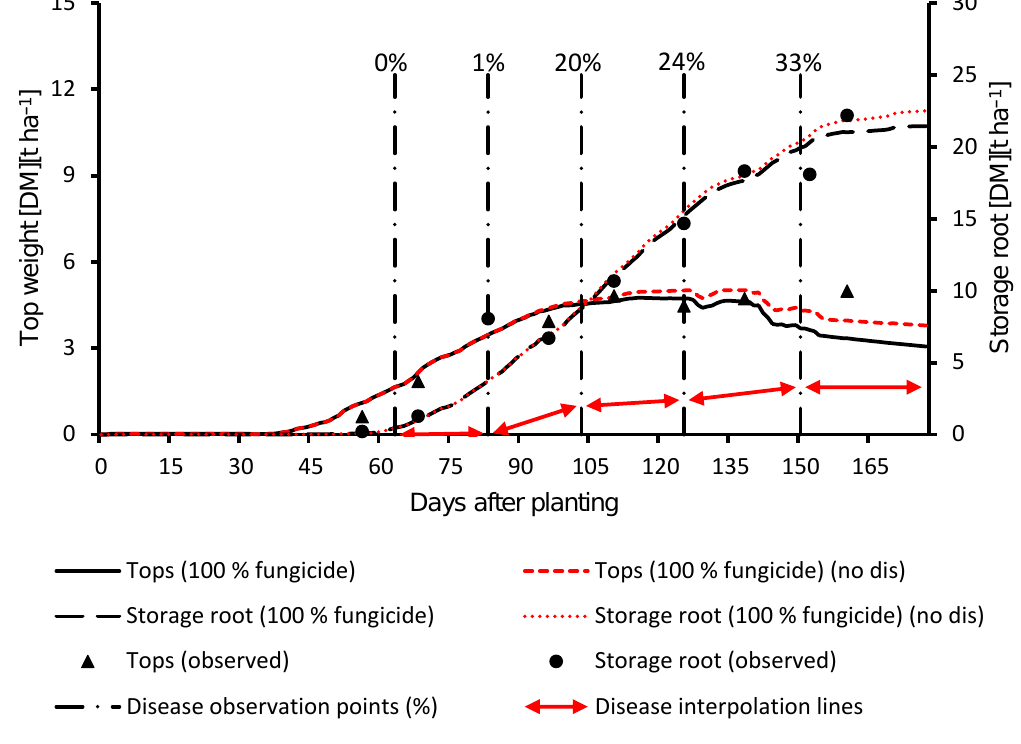
Figure 6. Simulated and observed values with Cercospora leaf spot ratings included in the simulation results: (y0 axis) top weight; (y1 axis) storage root weight and observed Cercospora leaf spot disease ratings on specific dates, and sugar beet growth simulated with current genetics without disease ratings being included in the simulation process as “no dis” treatment (100% fungicide in 2016) of top and storage root weight.